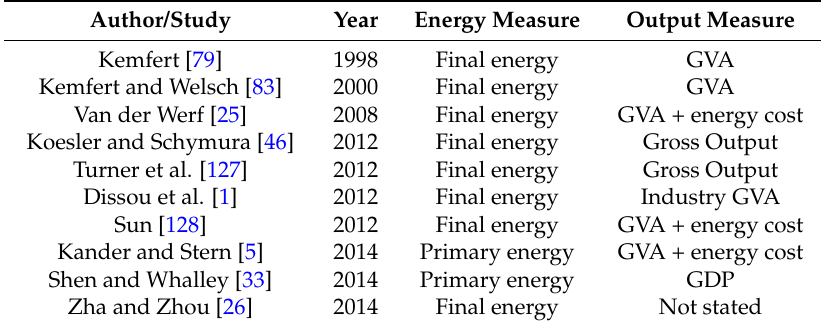
Table 1. Energy and output measures adopted for selected K-L-E empirical CES